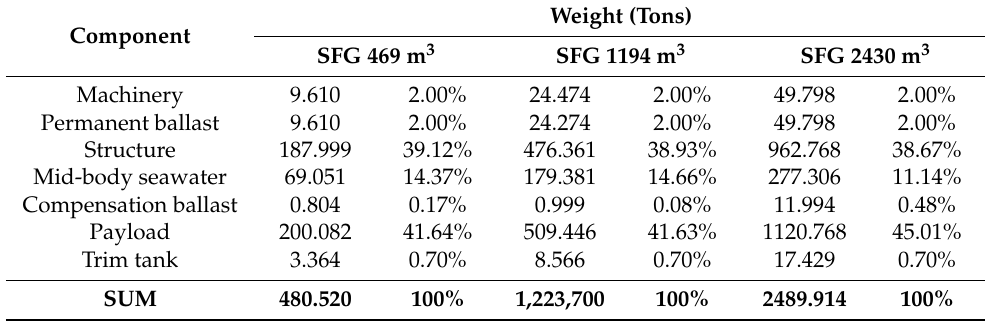
Table 6. Weight compensation for the individual SFG design (CO 2 -filled condition).